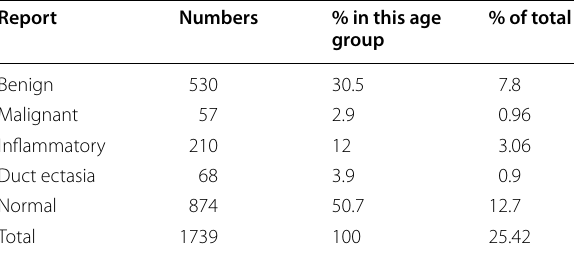
Table 3 Frequency of lesions in patients < 30 years of age Report